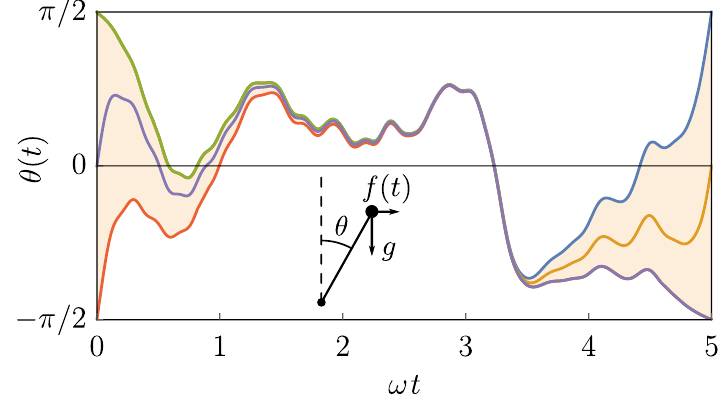
Figure 1: Examples of non-falling solutions to Eq. (1) bounded to the strip | θ ( t ) | < π/ 2 for a particular realization of the drive f ( t ) at the interval ( 0, T ) with ω T = 5. For any choice of θ and θ within the strip, there exists a unique trajectory 1 2 satisfying the boundary conditions θ ( 0 ) = θ and θ ( T ) = θ . In the limit T → ∞ , 1 2 the bundle of these trajectories (shown by filling) becomes infinitely thin, thus defin- ing a unique never-falling trajectory , whose statistical properties are studied in our paper. Inset: sketch of a driven inverted